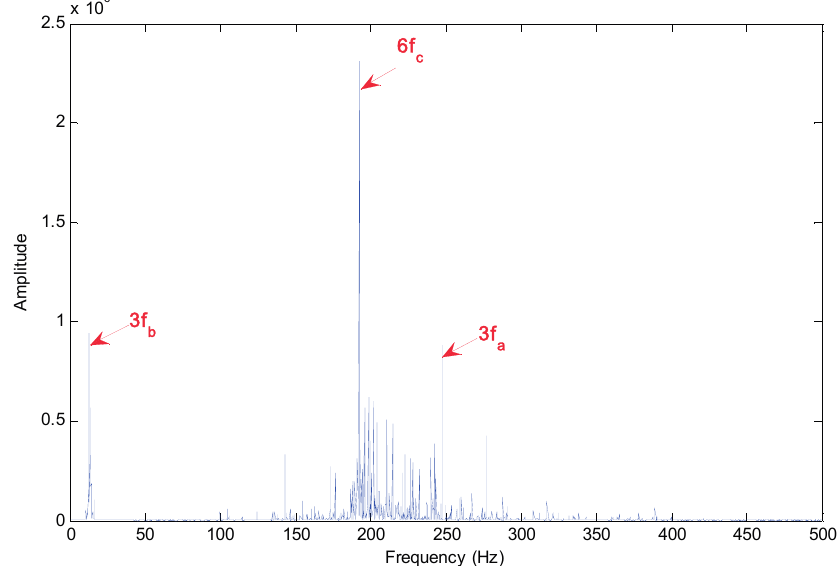
Figure 16. Hilbert marginal spectrum of selected IMFs for axle bearing vibration signals with a composite of three kinds of